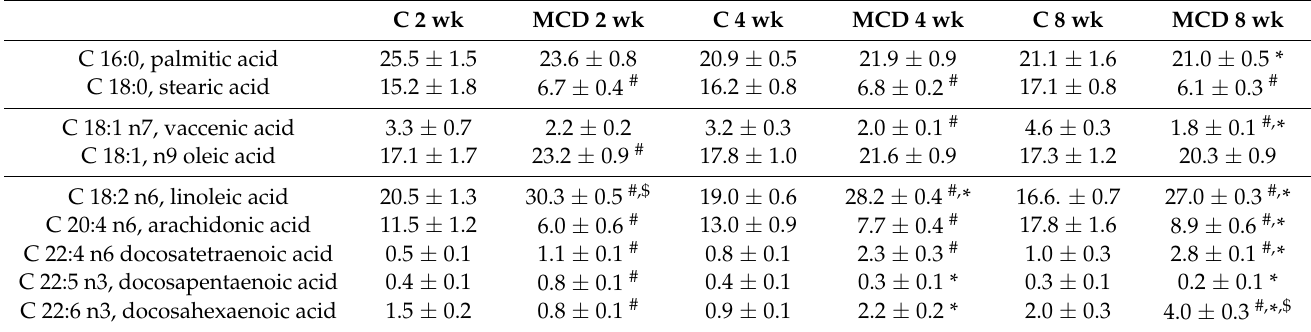
Table 7. Changes in fatty acids in rats fed MCD diet.